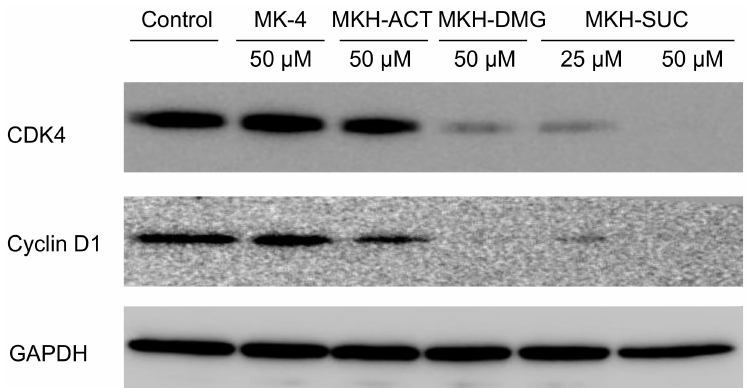
Figure 7. Effects of MKH-ester prodrugs or MK-4 on the expression of the cell cycle regulatory proteins cyclin, D1 and CDK-4, in PLC/PRF/5 cells at 24 h after